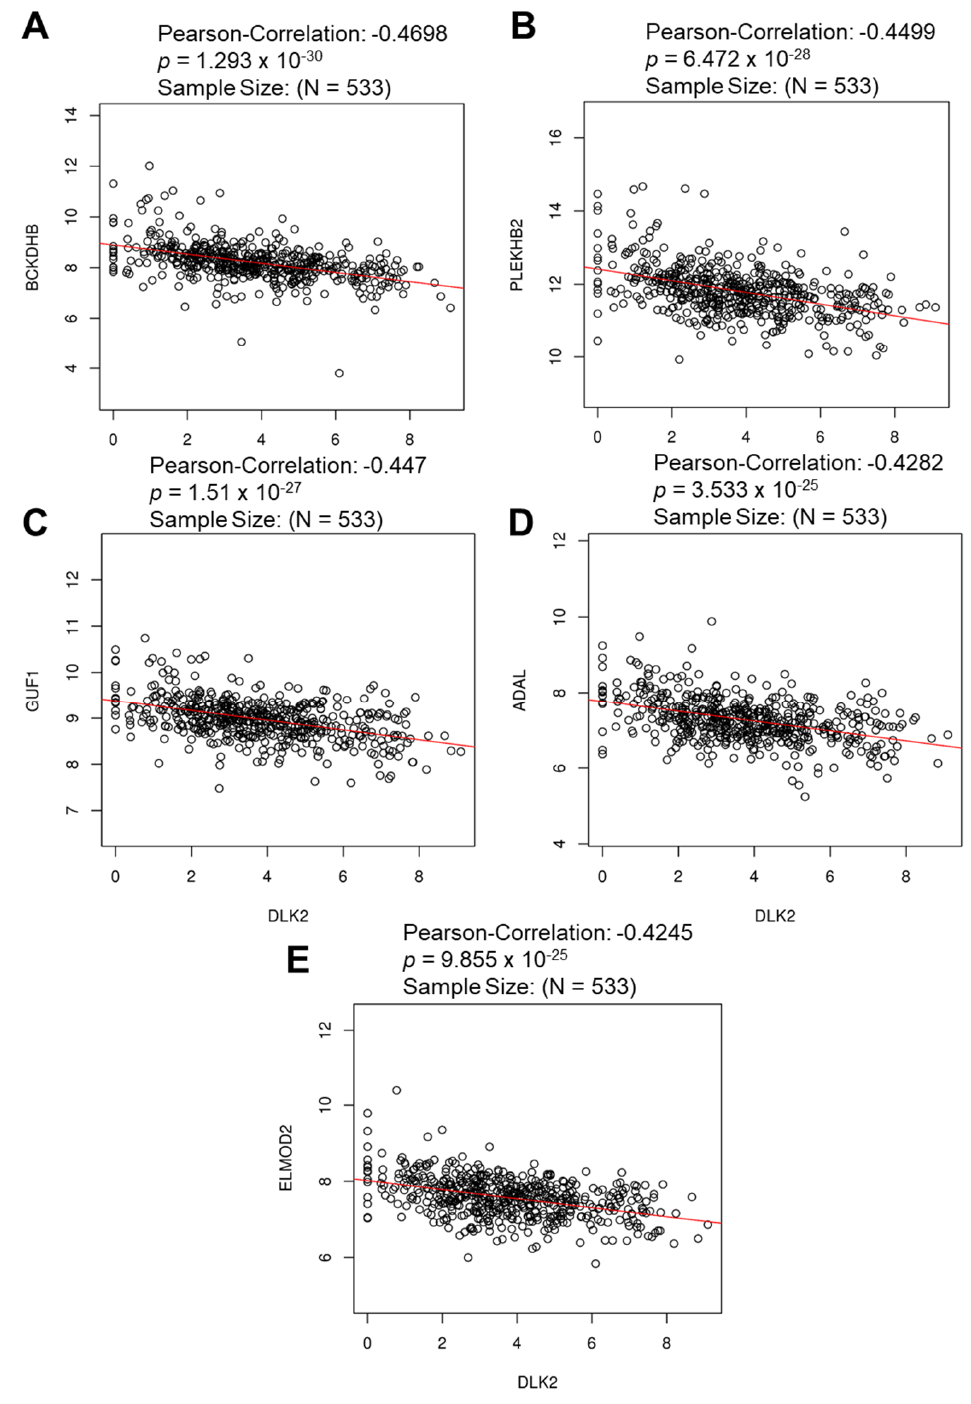
Figure 7. The top five genes negatively correlated with the DLK2 level in ccRCC are identified using LinkedOmics database. Pearson’s correlation analysis for the relationship between DLK2 level and